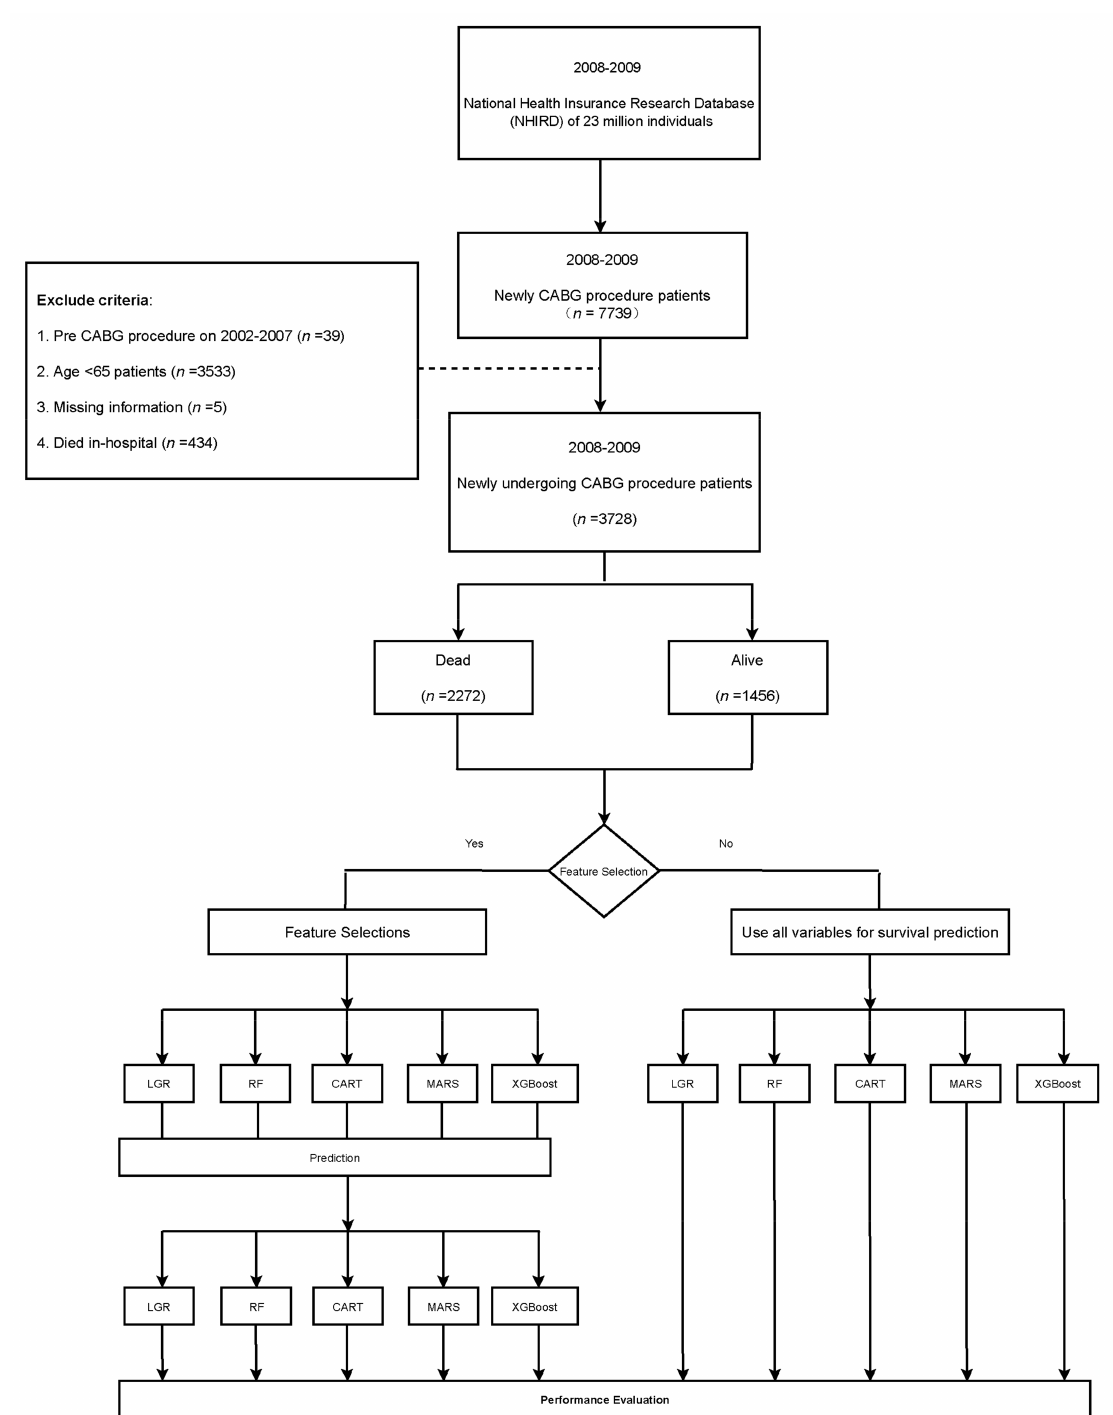
Figure 1. Patient selection and further analysis of 3728 older adult patients who had undergone first-time coronary artery bypass surgery grafting (CABG) between 2008 and